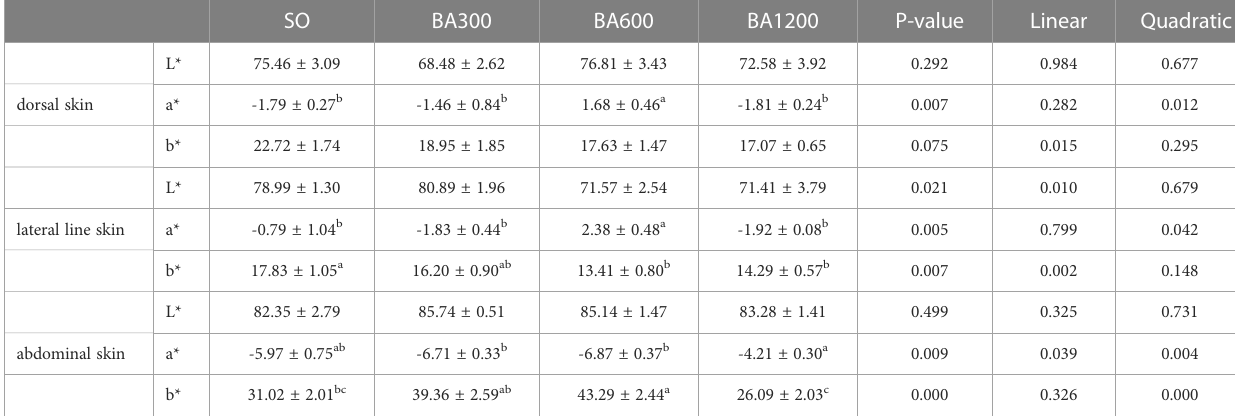
TABLE 5 Skin color parameters of juvenile large yellow croaker in different treatments (Means ± SEM, n = 3) 1 .